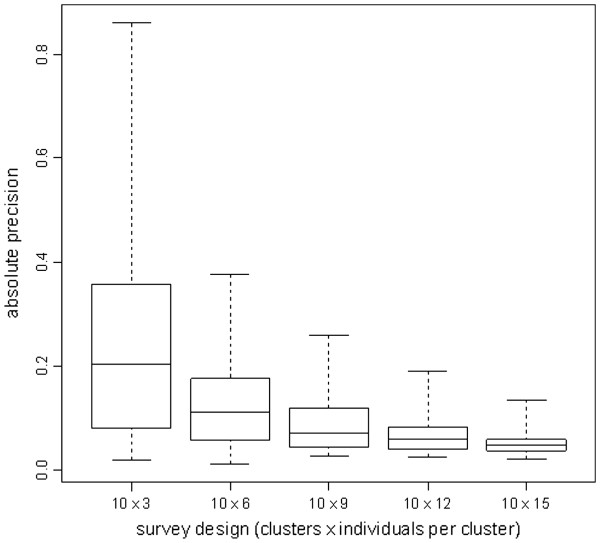
Absolute precision of estimates of the intra-cluster correlation coefficient of VC, for different survey designs. Box plots indicate the median and inter-quartile range of the median absolute precision values from 10 000 bootstrap replicates of each of the 41 stratum surveys. Whiskers denote the range.